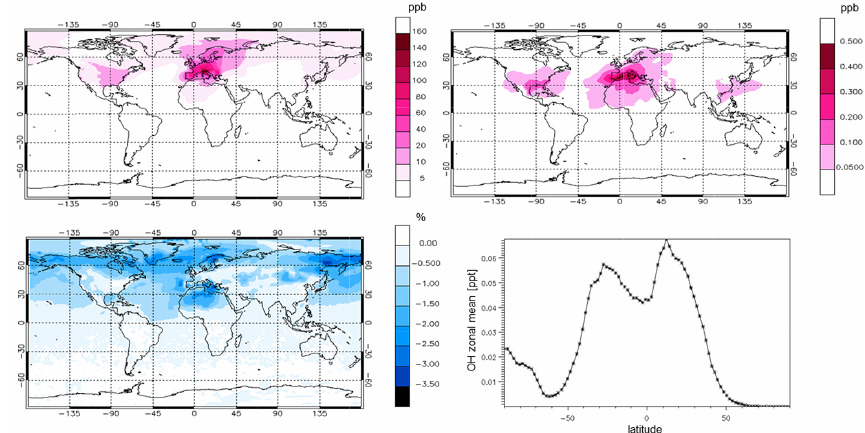
Figure 12. Difference (MI-OPT − MI-DEP) of monthly mean surface level mixing ratios for January 2008. Top panels: CO (left) and ozone (right) absolute bias in parts per billion. Bottom panels: OH relative bias in percent and absolute MI-DEP zonal mean OH mixing ratios in parts per